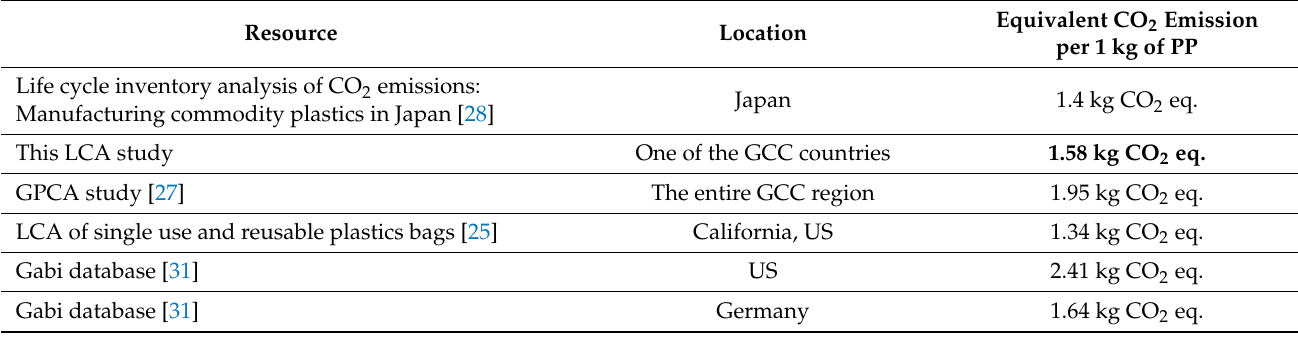
Table 4. A relative comparison of the gross carbon dioxide emission results per 1 kg of PP between this LCA study and two previous LCA studies. Resource